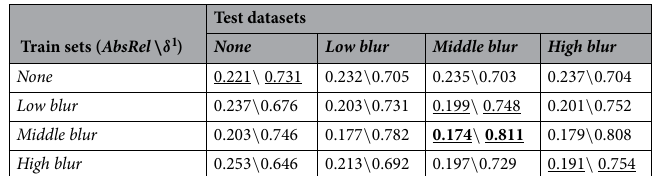
Table 6. The model shows the different accuracy results under different motion blurs. The best result in each row is underlined and the optimal result is bolded.